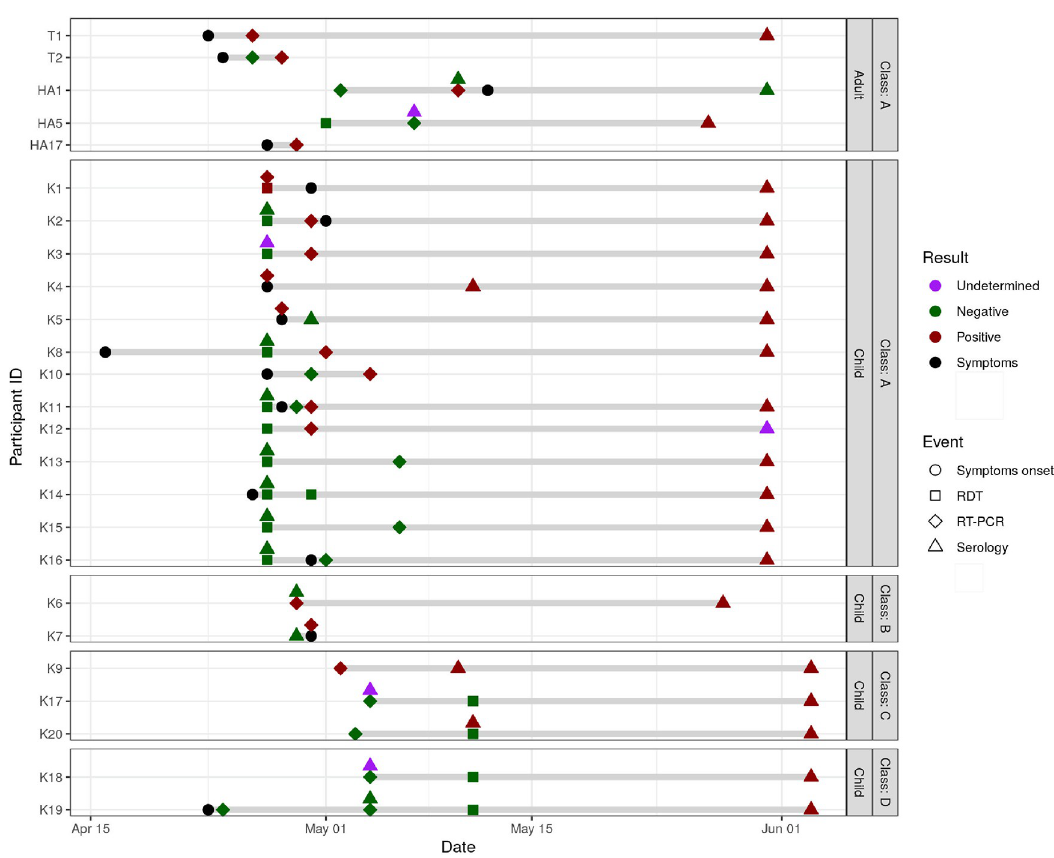
Fig 2. Timeline of symptoms onset, diagnosis and virological analyses among cases with a confirmed SARS-CoV-2 infection (positive RDT, RT-PCR or seroconversion). Apr: April, HAx: Adult member of household, HCx: Child member of household, Jun: June, Kx: Kid x, Tx: Teacher x, RDT: antigen rapid diagnostic test, RT-PCR: real-time reverse transcription polymerase chain